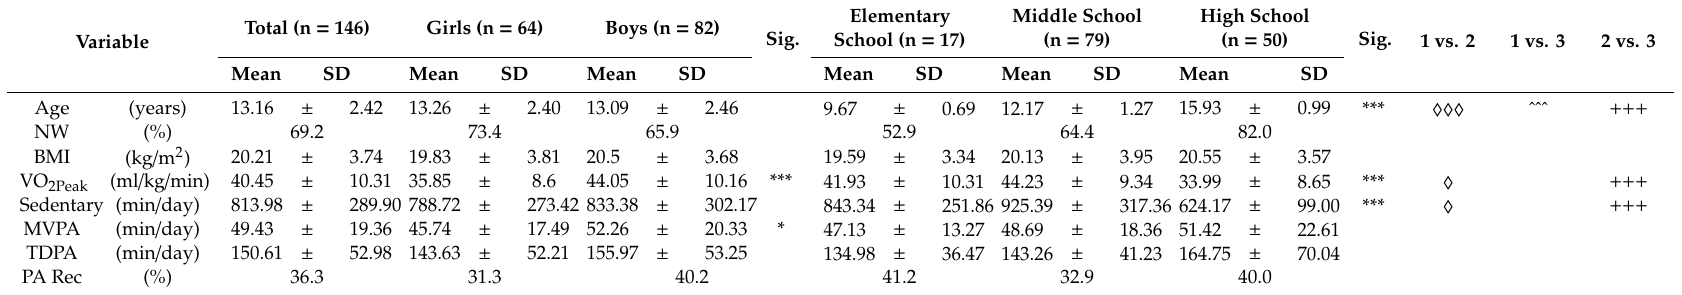
Table 1. Descriptive characteristics of the